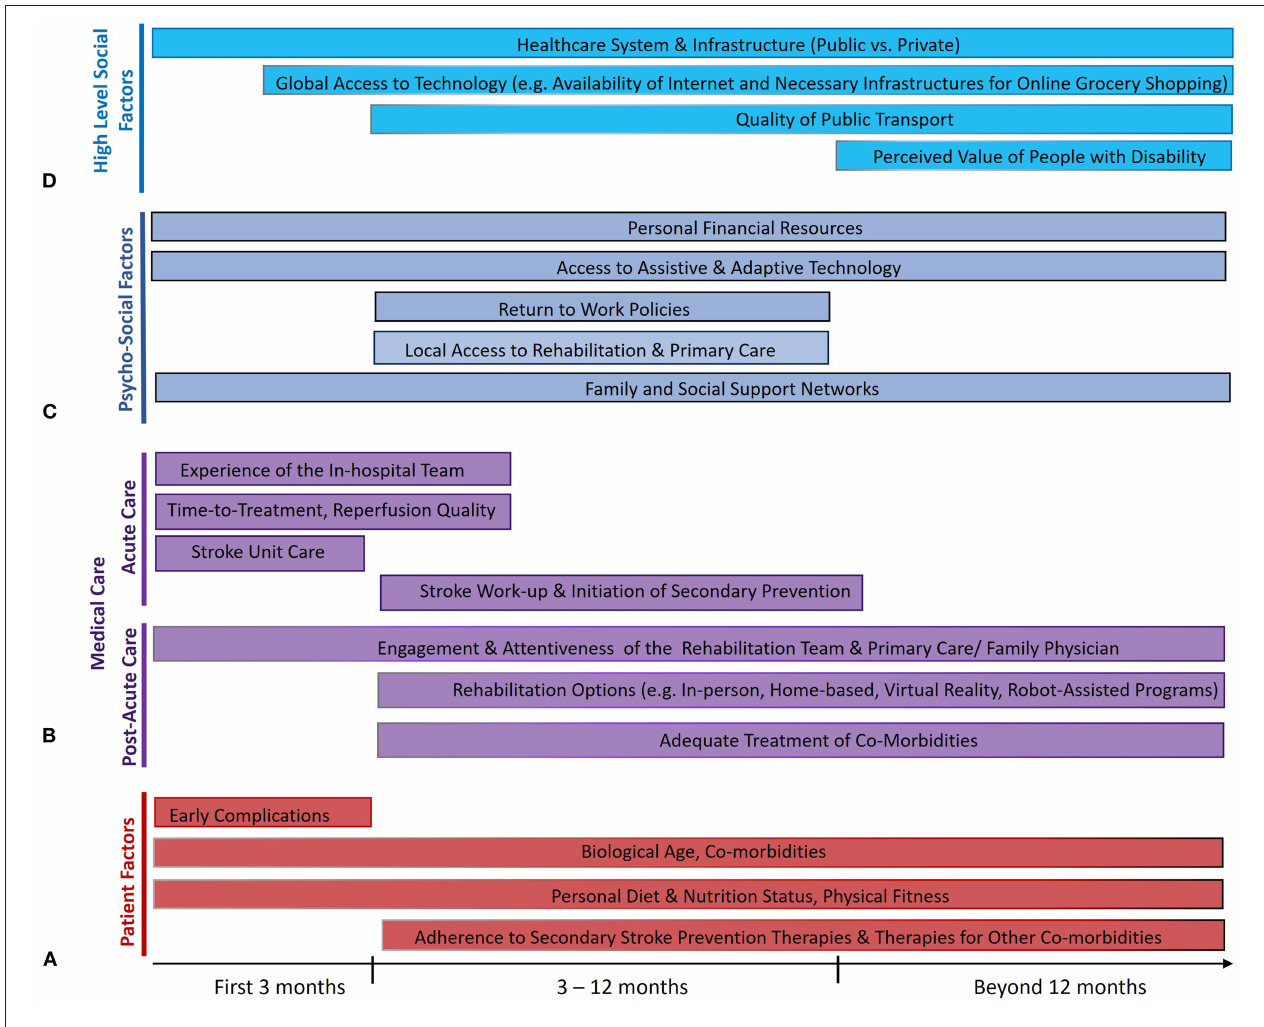
FIGURE 1 | Factors that influence the maintenance of treatment benefits of endovascular therapy (EVT) from 3 months to 5 years after ischemic stroke from large vessel occlusion. Several factors relate to the individual patients themselves (A) , some of which are modifiable (like risk of early complications) and rely on effective collaboration between patients and physicians, while several others directly relate to the quality of acute and post-acute medical care (B) . Many psychosocioeconomic factors in the life of the patient also play a crucial role (C) , as do higher-level societal factors (D) that influence the ability of the patient to reintegrate post-stroke and live a fulfilling life. The length of the bars reflects the portion of the post-stroke time period where each factor is thought to play an important role. occurs in the context of integrated systems of stroke care.